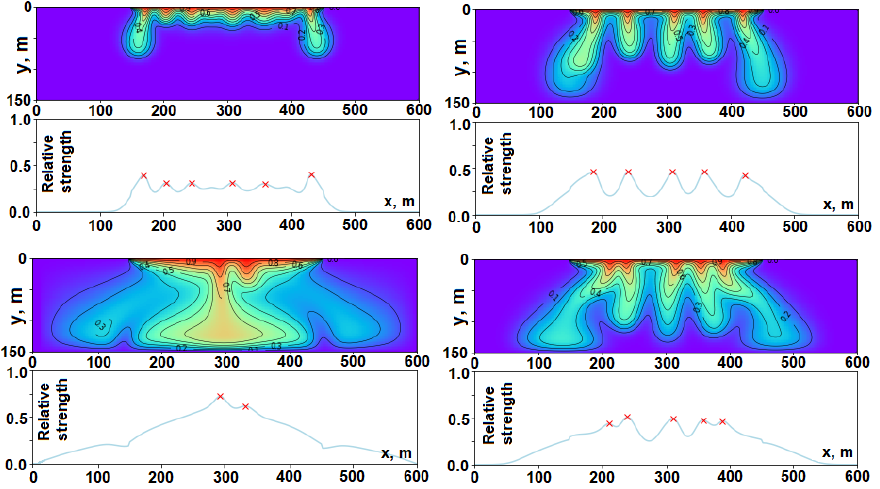
Figure 6. Examples of the curve (9) and the peaks (the x markers in red) corresponding to the solution fingers.